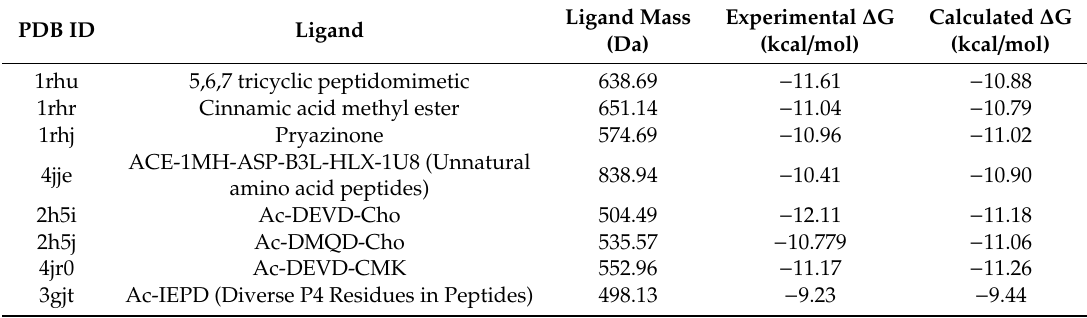
Table 2. Comparison of the binding free energy calculated by Moveable Type to that obtained from experiment for the caspase-3—peptidomimetic molecule inhibitor test set.